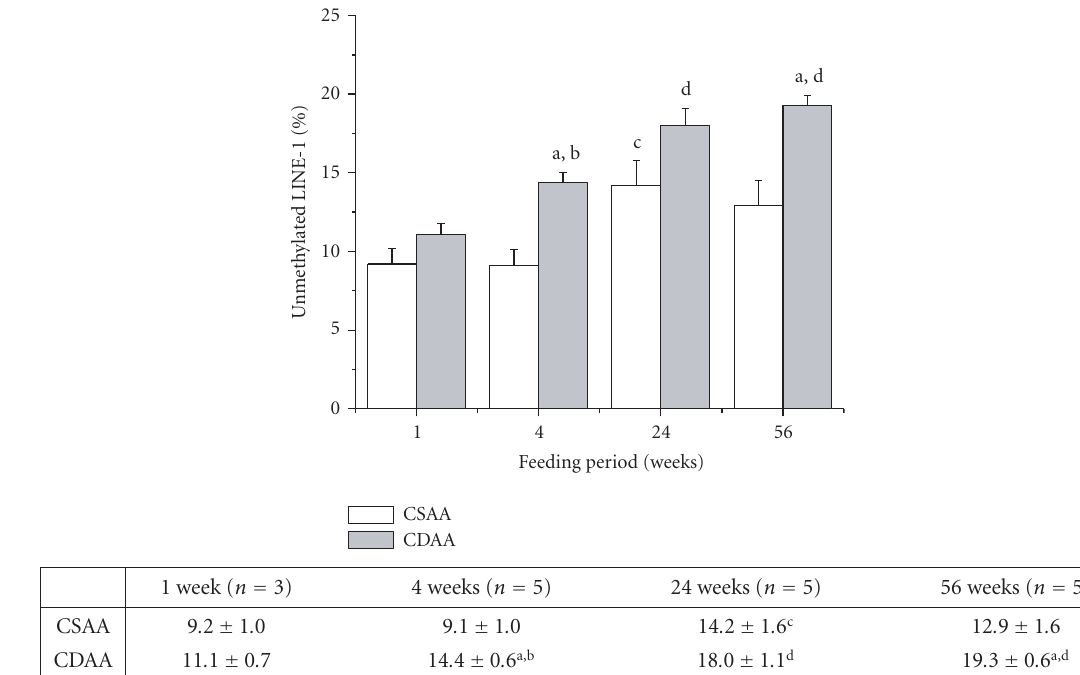
Figure 3: Percentage of unmethylated cytosine versus total (methylated plus unmethylated) cytosine in LINE-1 sequences in the livers of CSAA- and CDAA-diet fed rats. Actual data are shown in the table under the graph. Symbols: (a) significantly di ff erent from CSAA at the same feeding period; (b) significantly di ff erent from CDAA at 1 week; (c) significantly di ff erent from CSAA at 1 and 4 weeks; (d) significantly di ff erent from CDAA at 1 and 4 weeks. % ± SE; standard